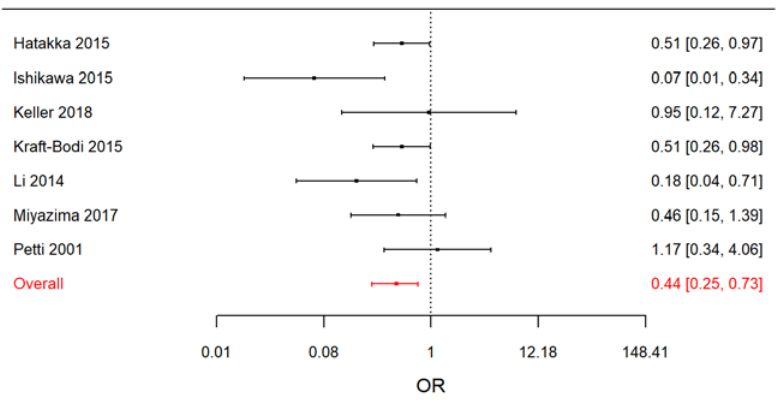
Figure 7. Forest plot from the Bayesian random-effects meta-analysis of the randomized controlled studies on adults. Table 3. Summary of the results from the Bayesian random-effect meta-analyses. CrI—credibility interval.